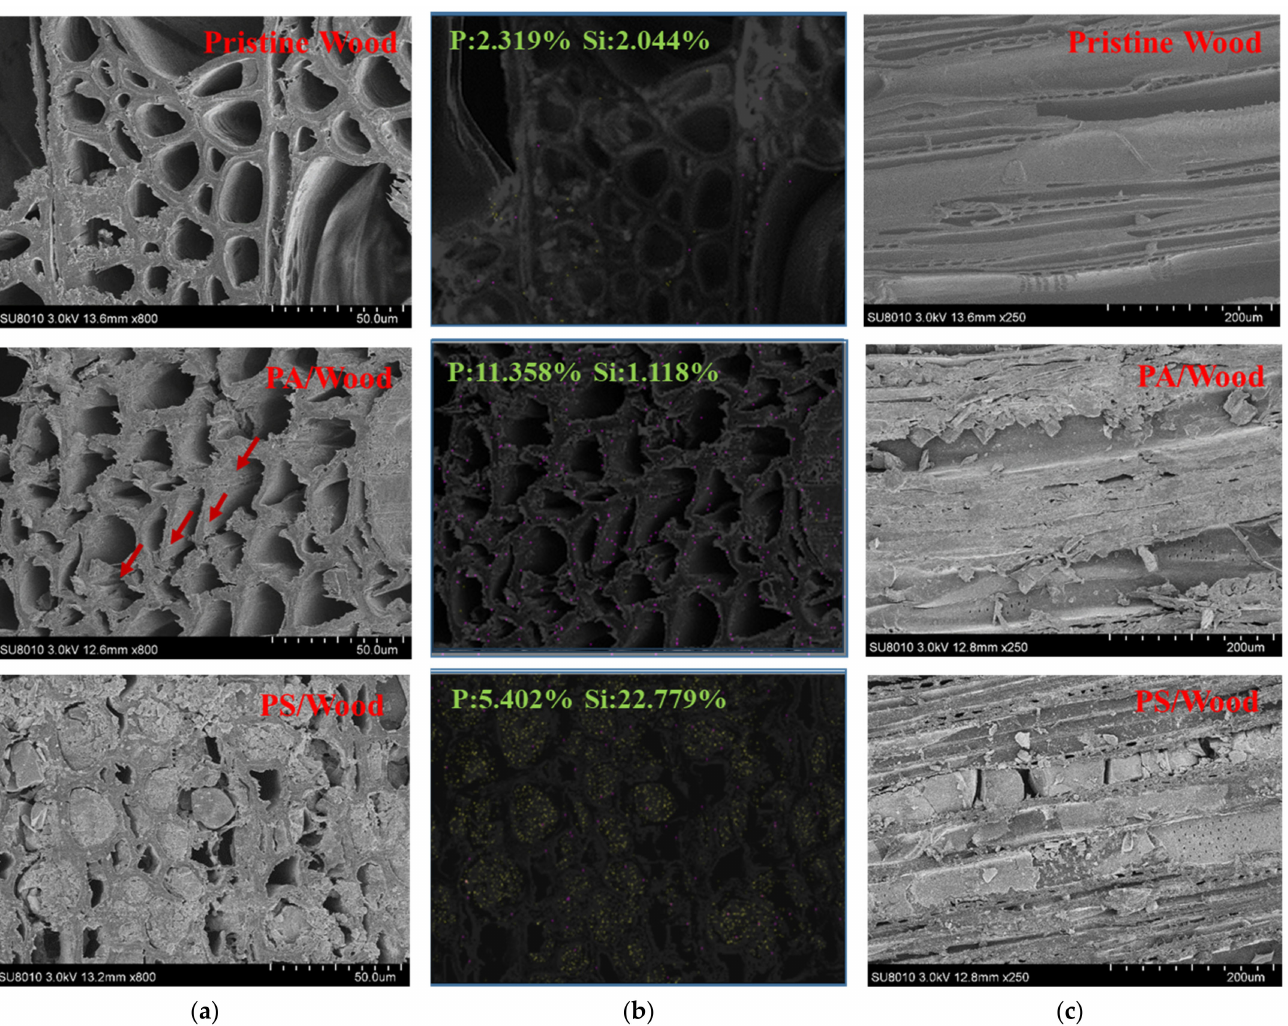
Figure 6. SEM micrographs of the wood samples: ( a ) cross sections ( × 800 magnification); ( b ) EDS tomographies of the cross sections, purple represents the P element, and yellow represents the Si element; ( c ) tangential sections ( × 250